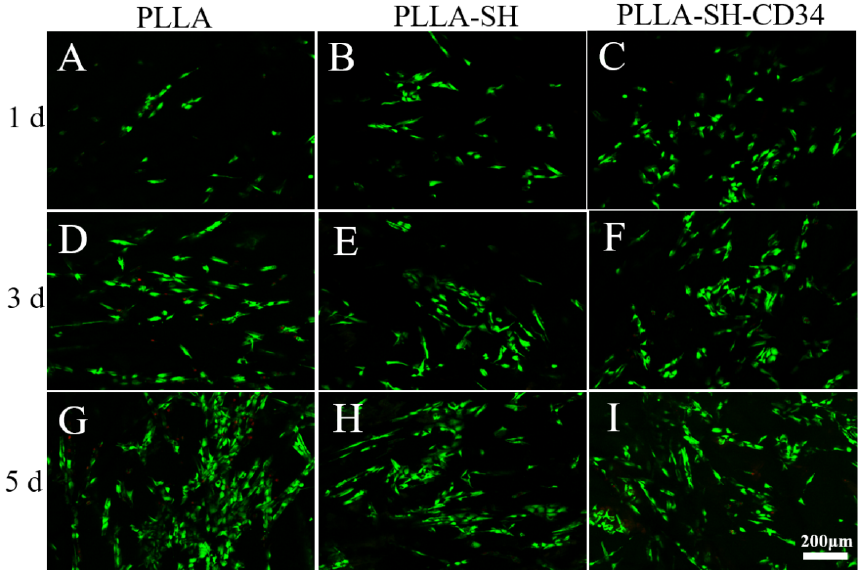
Figure 8. Live/dead staining of endothelial cells on different scaffolds on days 1, 3, and 5.